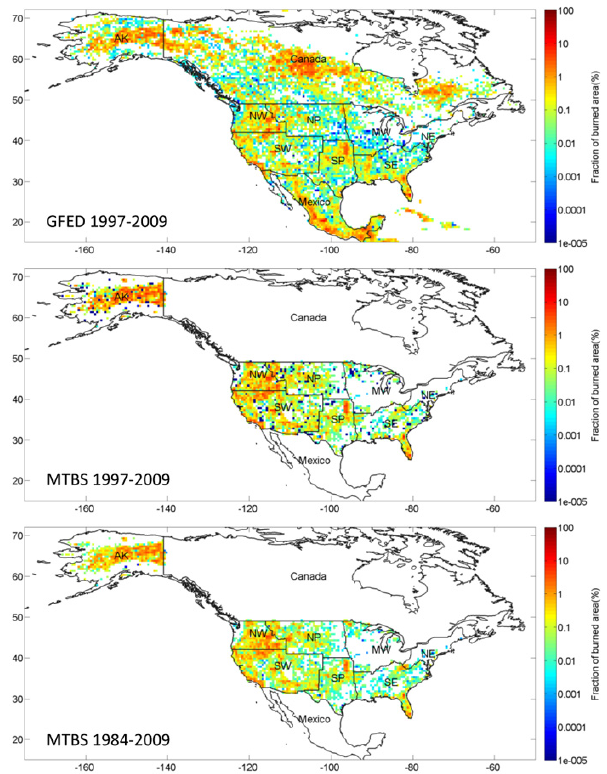
Fig. 1. Mean annual GFED BA (1997–2009, top) and MTBS BA (1997–2009, middle; 1984–2009, bottom), shown as the burned fraction of each 0.5 ◦ grid cell. Sub-national study regions are out- lined in black: Alaska and Arctic (AK), Northwest (NW), South- west (SW), Northern Plains (NP), Southern Plains (SP), Midwest (MW), Southeast (SE), and Northeast